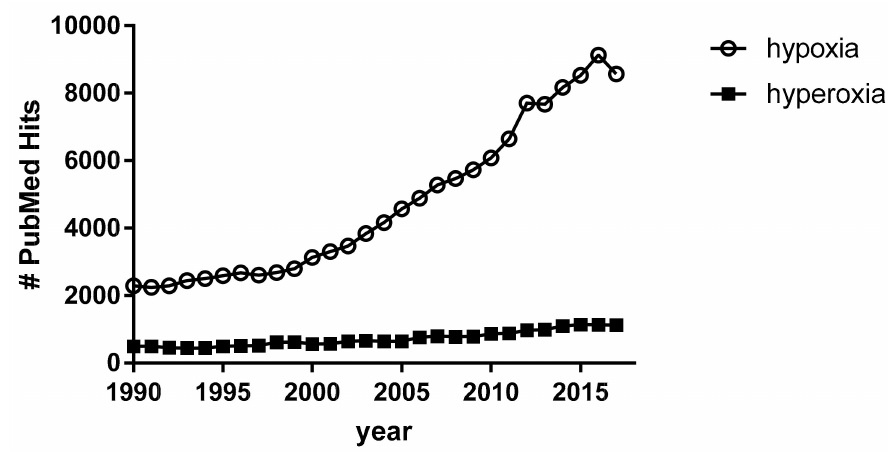
Figure 1. PubMed hits per year for “hypoxia” vs. hits for